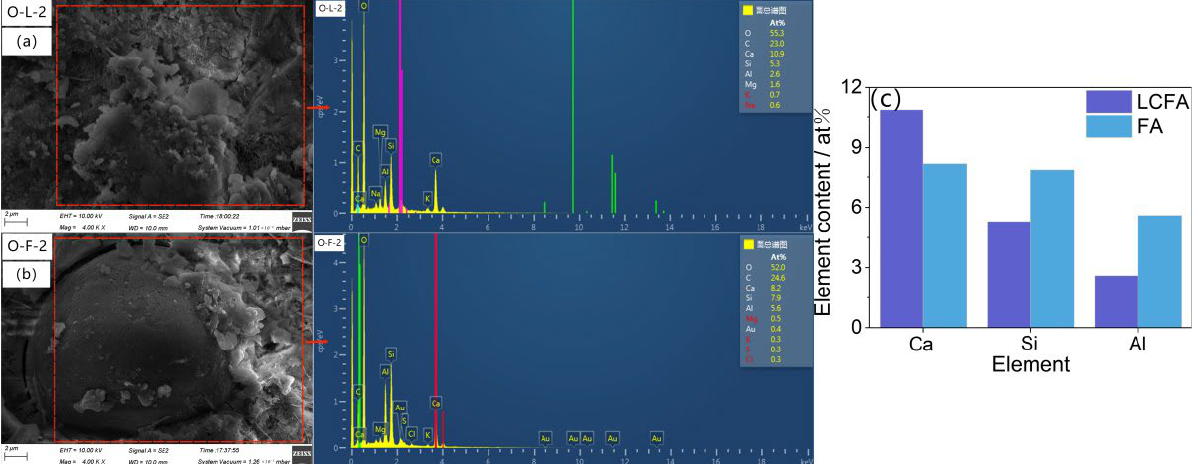
Figure 19. EDS results of OPC-LCFA ( a ) samples and OPC-FA ( b ) samples at 28 days, ( c ) contents of